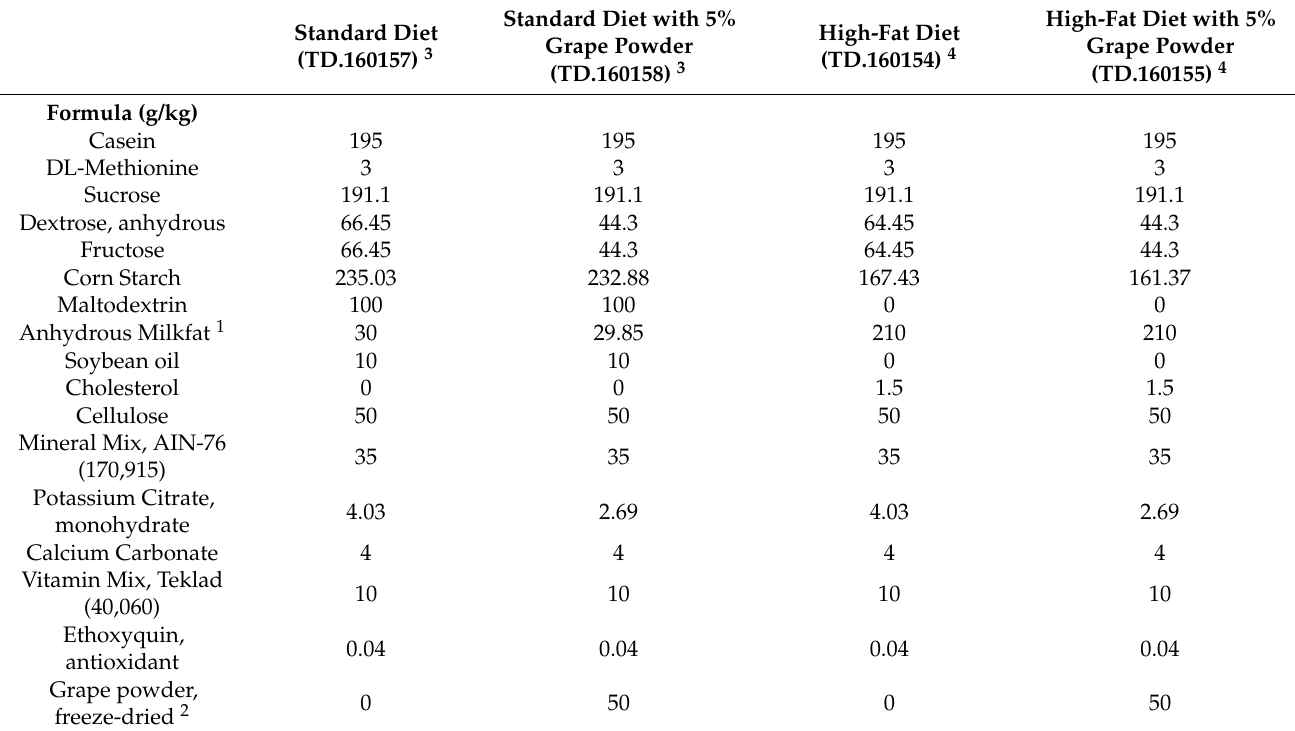
Table 1. Dietary constituents: 4% fat standard diet (STD; TD.160157); STD + 5% ( w / w )